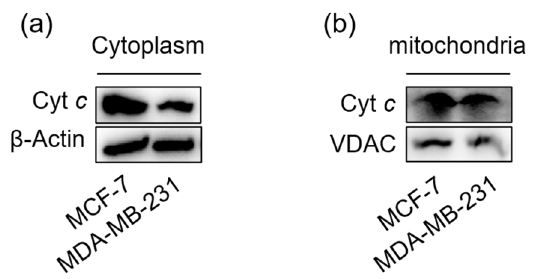
Figure 5. Expression levels of Cyt c in cytoplasm ( a ) and mitochondria ( b ) in MCF-7 cells and MDA-MB-231 cells, respectively, with those of β -Actin and VDAC shown for MDA-MB-231 cells, respectively, with those of β -Actin and VDAC shown for comparison. To reveal whether the overexpressed Cyt b 5 interacts with Cyt c in MDA-MB-231 cells, we tested the combination of Cyt b 5 and Cyt c by co-immunoprecipitation (Co-IP)